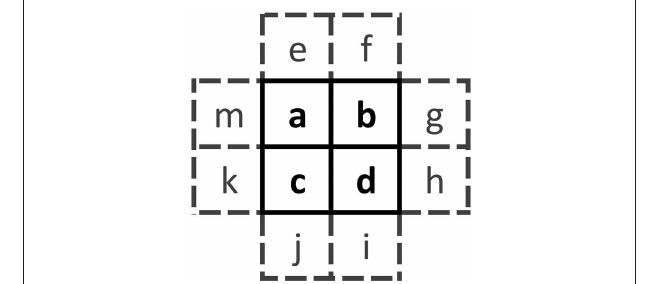
equations in matrix-vector product